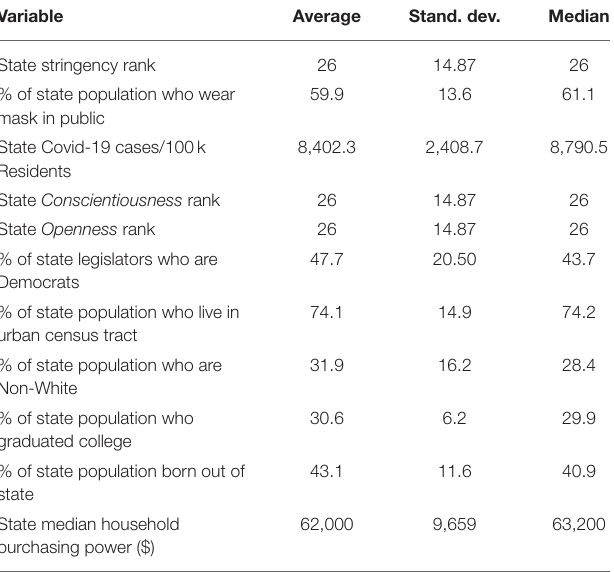
TABLE 1 | Descriptive statistics used in the